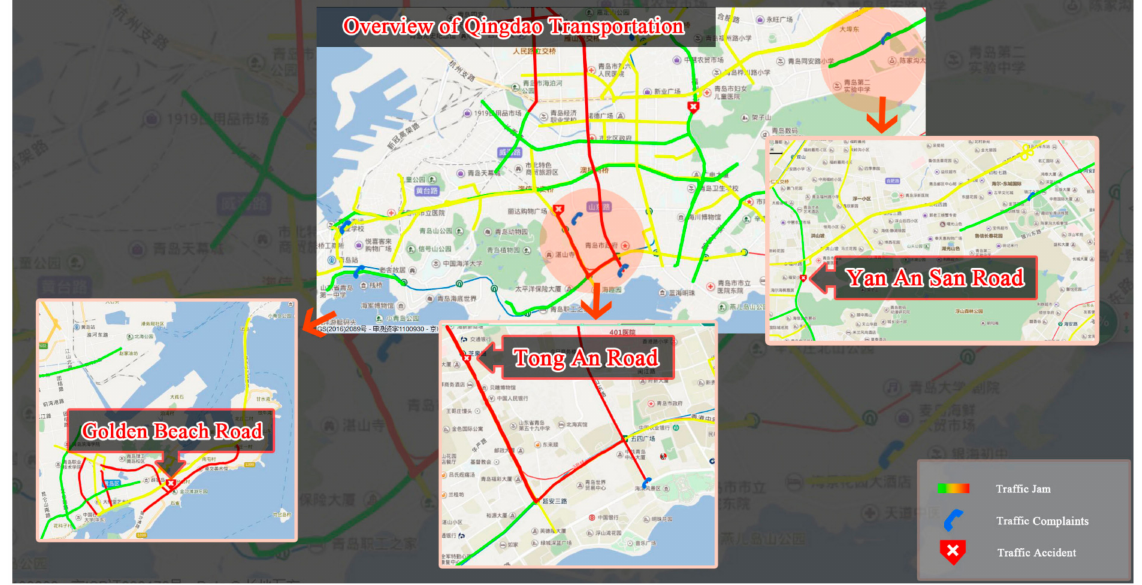
Figure 7. Overview of Qingdao transportation on 4 August